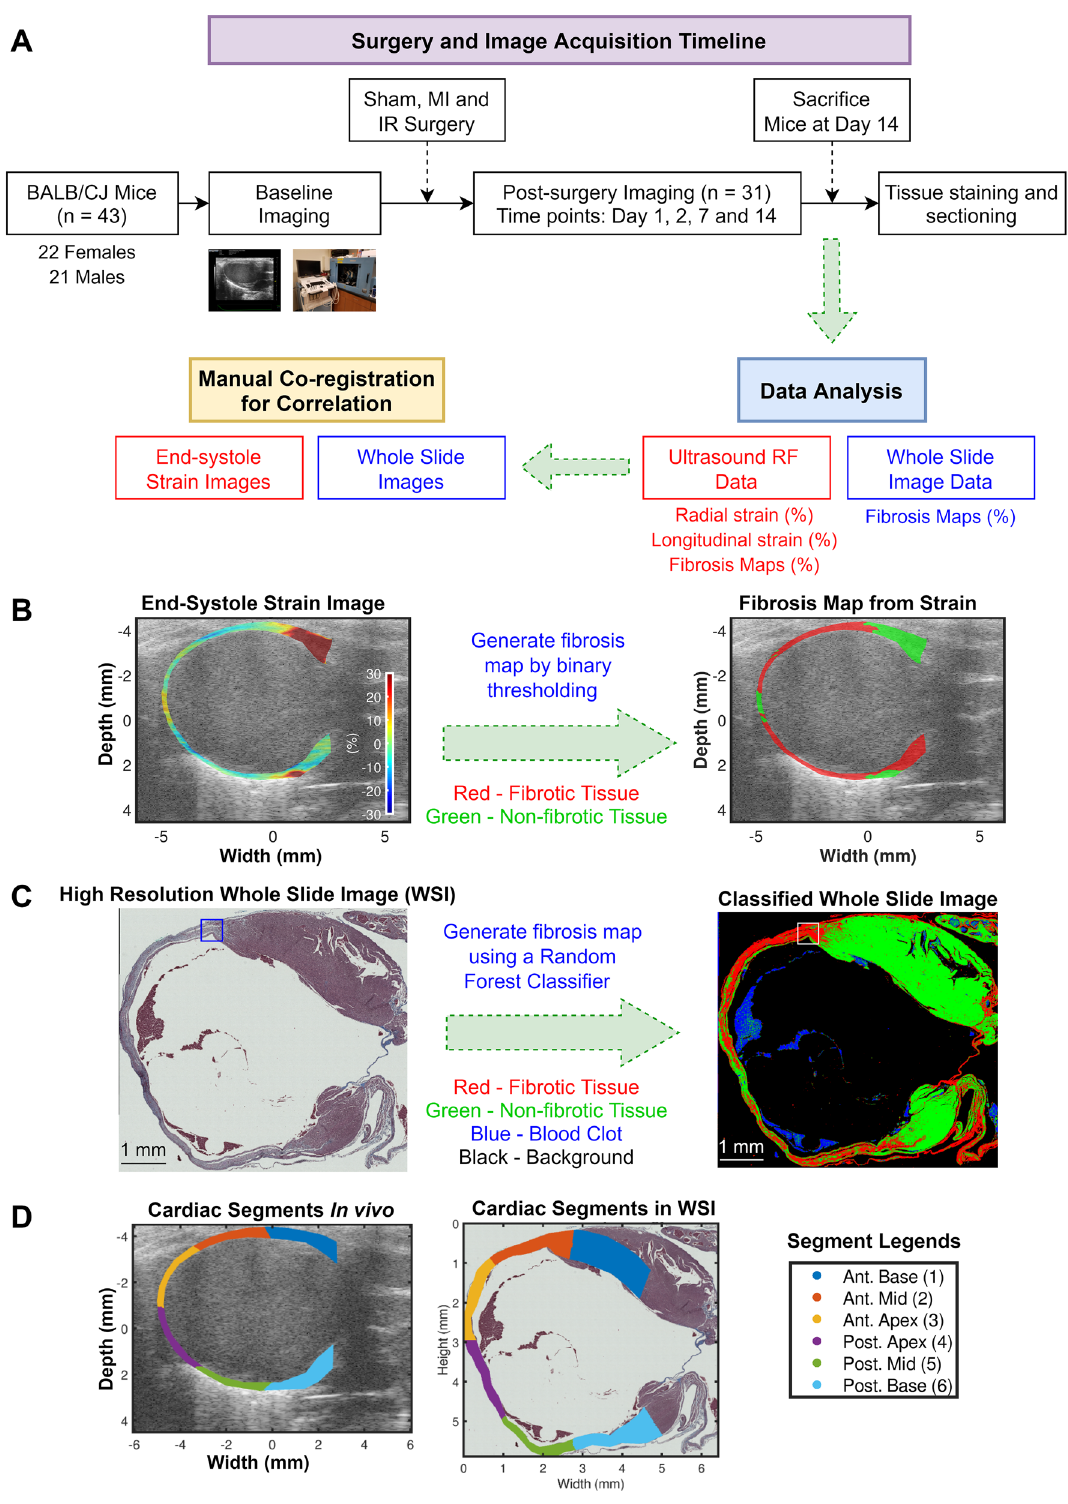
Figure 1. Cardiac fibrosis localization using adaptive Bayesian regularized cardiac strain imaging (ABR-CSI) in vivo. ( A ) Experimental protocol for histopathological validation of proposed ABR-CSI in murine models of myocardial infarction (MI) and ischemia–reperfusion (IR). High frequency ultrasound RF data collected pre- and 1, 2, 7 and 14 days post-surgery were used for strain estimation. ( B ) Method for estimating cardiac fibrosis using cumulative ES strain images in vivo. ( C ) Method for estimating cardiac fibrosis using high resolution WSI ex vivo. A random forest classifier detects four classes in the raw WSI: fibrotic, non-fibrotic regions, blood clots and background. ( D ) Cardiac segment definitions for regional analysis. Ant. anterior and Post.